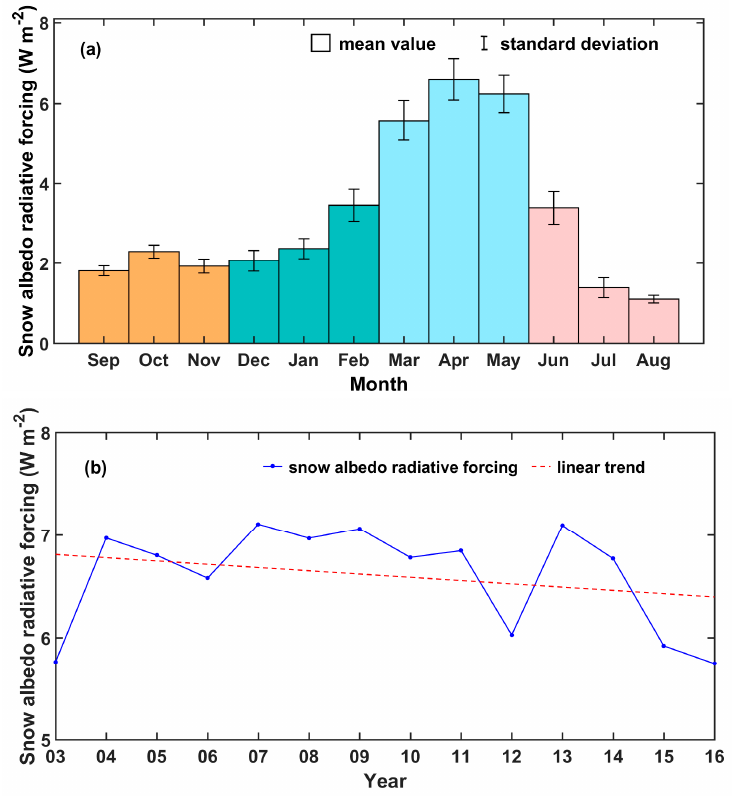
Figure 5. Snow albedo radiative forcing over the North Hemisphere Extratropical Land during 2003–2016: ( a ) climatological monthly mean; and ( b ) April interannual variability.